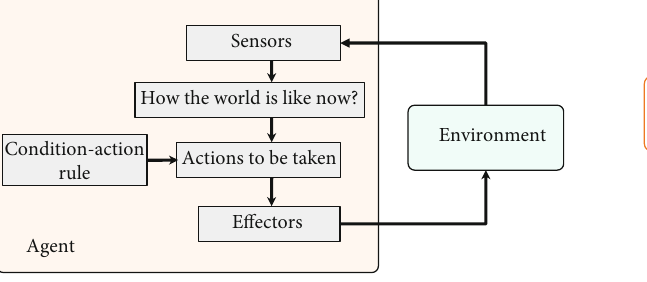
Figure 1: Smart agent concept.